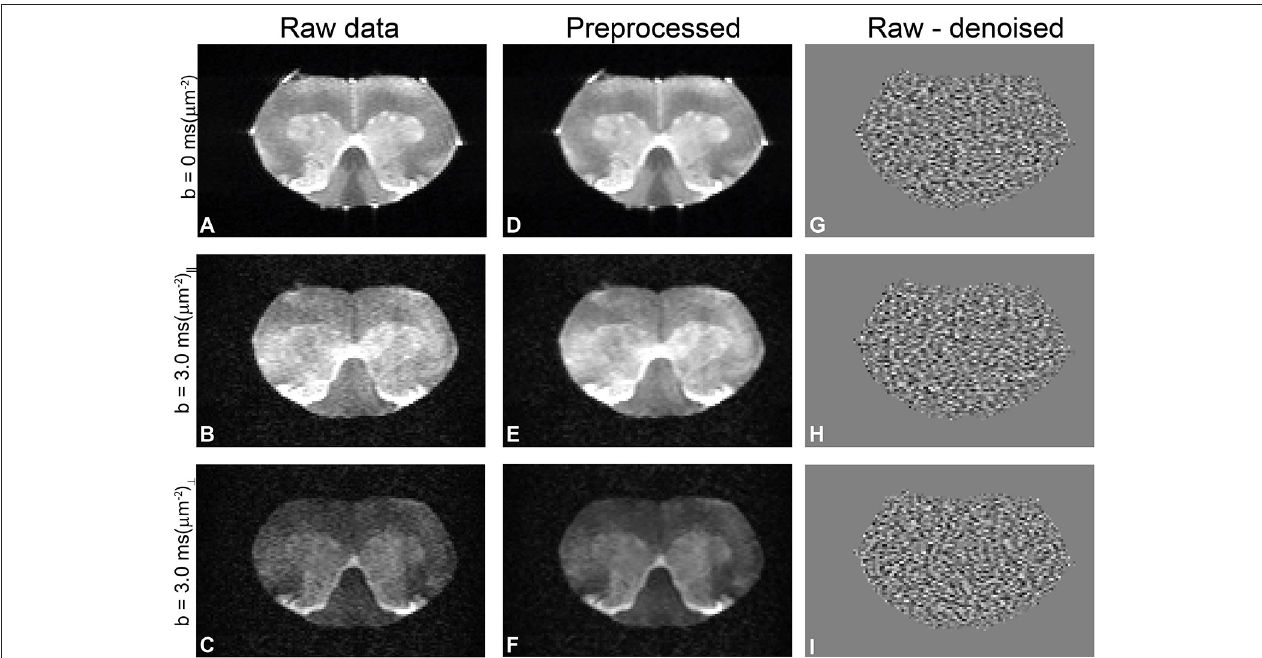
FIGURE 2 | Quality of diffusion MRI data and preprocessing in a representative spinal cord. (A–C) Raw data with zero b -value, parallel, and perpendicular waveforms acquired at the highest b -value, respectively. In this particular direction, the perpendicular waveform had more significant components along the spinal cord principal axis and thus show greater attenuation. (D–F) Results of preprocessing the data in A–C (denoising and Gibbs unringing). Notice how the noise is highly reduced in the preprocessed images without adverse effects to image quality. (G–I) Subtraction of denoised and raw data, showing only noise and thus demonstrating that no significant signal components were removed during Marchenko-Pastur PCA denoising.